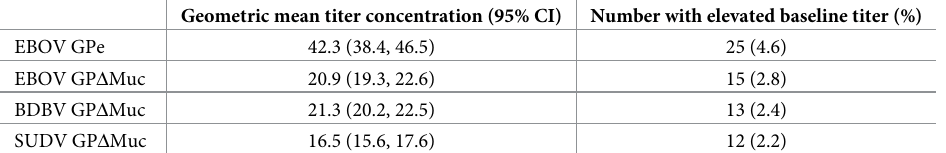
Table 2. Ebola virus-specific and ebolavirus cross-reactive antibody levels among 539 participants from Mban- daka and the surrounding areas in the Democratic Republic of the Congo, August 2018.